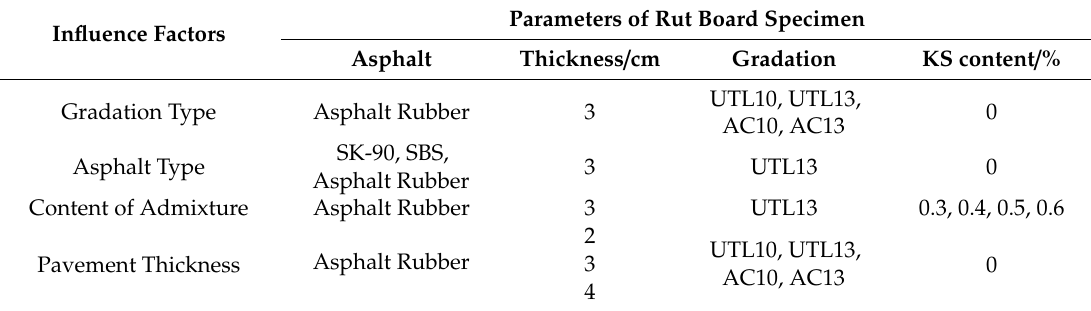
Table 3. The parameter combinations of rut board